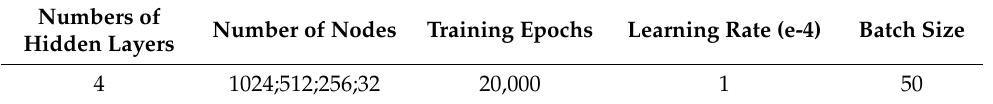
Table 2. Deep neural network hyper-parameters.